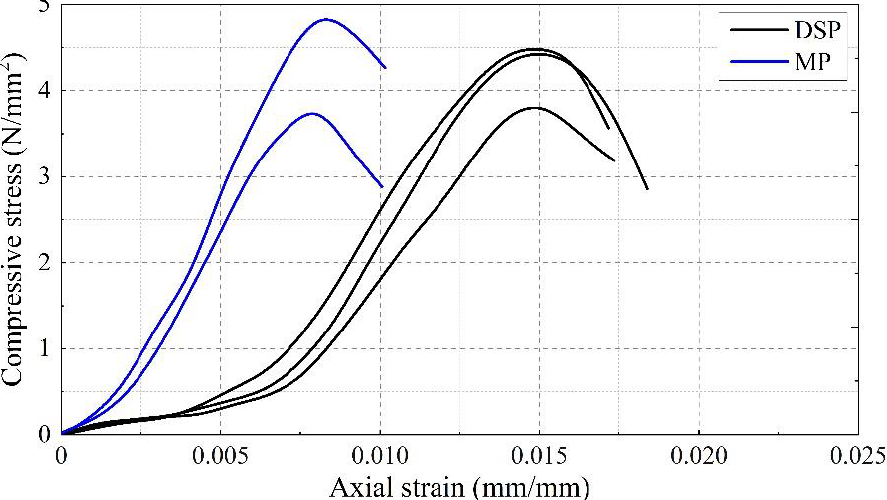
Figure 8. Stress – strain curves in compression of the prisms with dry stack (DSP) and mortar joints Figure 8. Stress–strain curves in compression of the prisms with dry stack (DSP) and mortar (MP). joints